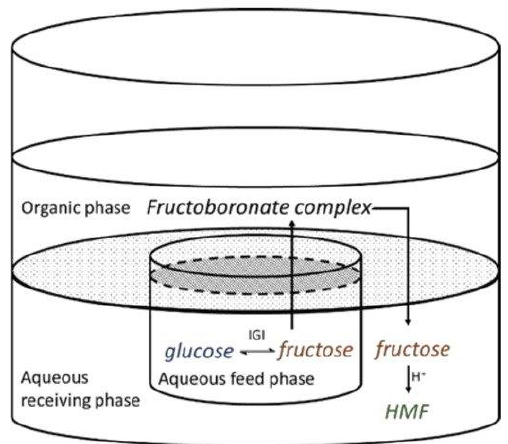
Figure 16. Concept of the compartmented sequential reactor with an organic solvent as the liquid membrane [116].